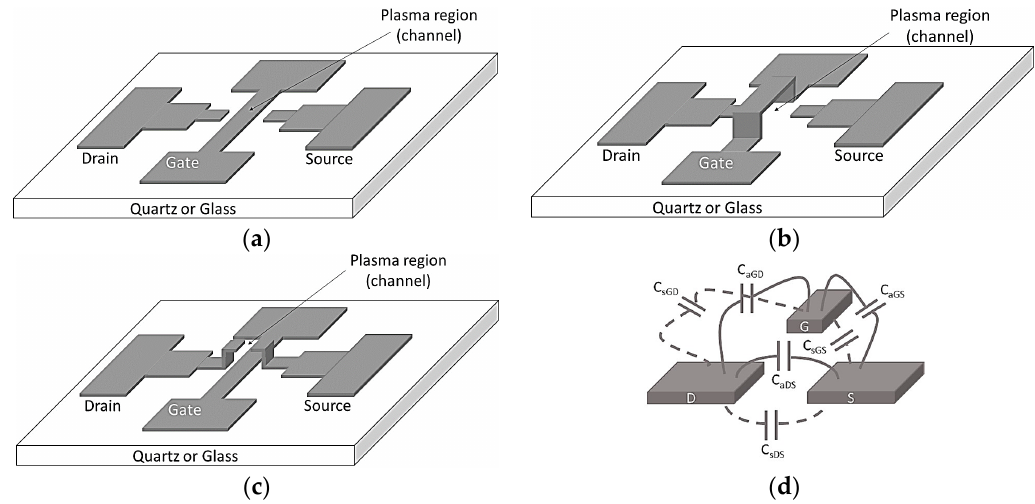
Figure 7. Schematics of different MOPFET geometries reported in the literature: ( a ) Planar MOPFET; ( b ) gate over the drain-source region; ( c ) drain and source electrodes over the gate region; and ( d ) different capacitances between the drain, source and gate electrodes.